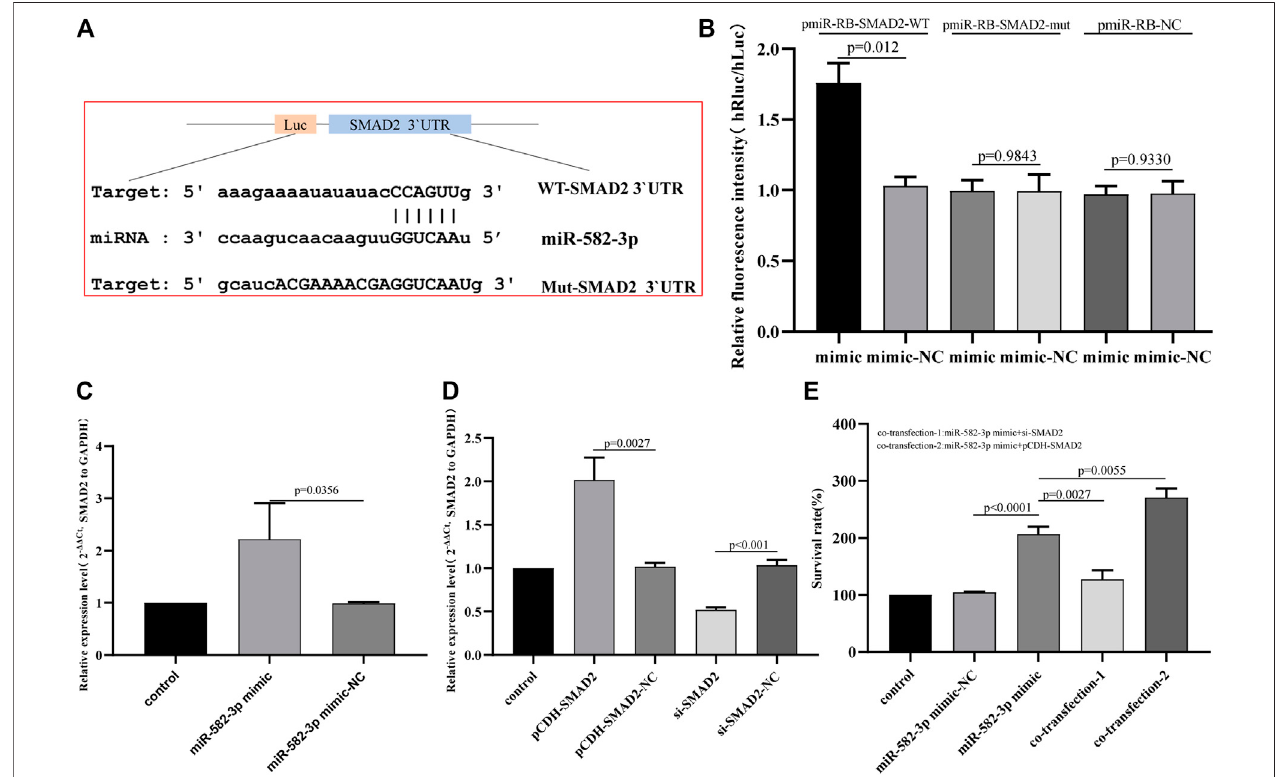
FIGURE 7| (A) Sequences ofmiR-582-3p and the SMAD2 3 ′ UTR binding sites. (B) Results ofthe dual-luciferase assay for miR-582-3p and SMAD2. (C) Analysis of the effect of miR-582-3p overexpression on SMAD2 expression in HepG2 cells by qPCR. (D) Changes in SMAD2 expression in HepG2 cells after the addition of pCDH-SMAD2 and si-SMAD2 by qPCR. The data are shown as the mean ± standard deviation. (E) The effect of SMAD2 interference with miR-582-3p on the proliferation of HepG2 cells by CCK-8.